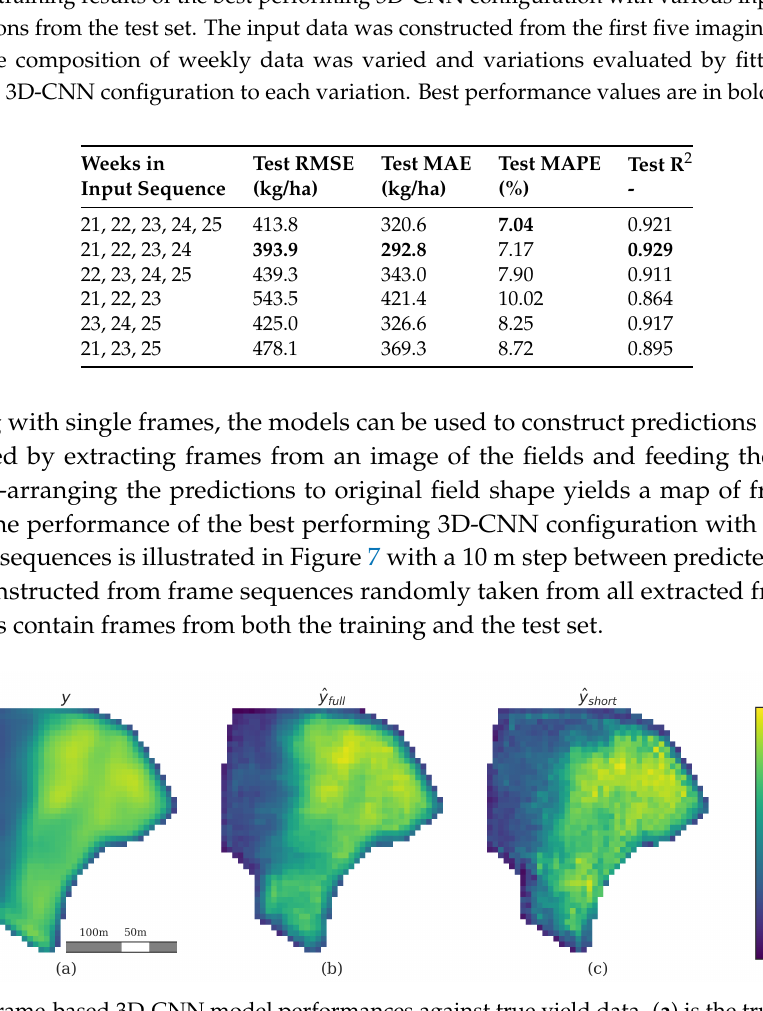
Figure 7. Frame-based 3D-CNN model performances against true yield data. ( a ) is the true yield map of the field. ( b ) is the modelled prediction, utilizing the full length frame sequences. ( c ) is then the actual in-season prediction utilizing four first frames of the weekly frame sequence. Units are absolute values in crop yield kg/ha. One pixel in the images corresponds to a 10 × 10 m area. Images are unsmoothed, represent the values as they were produced and contain samples from both training and test sets due to how the sets were